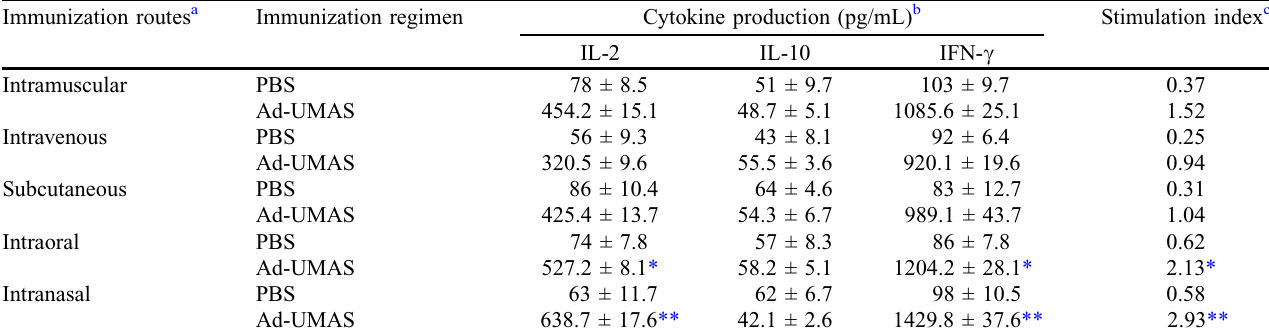
Table 3. Cytokine production and cell proliferative assay in the splenocyte cultures obtained from immunized mice.